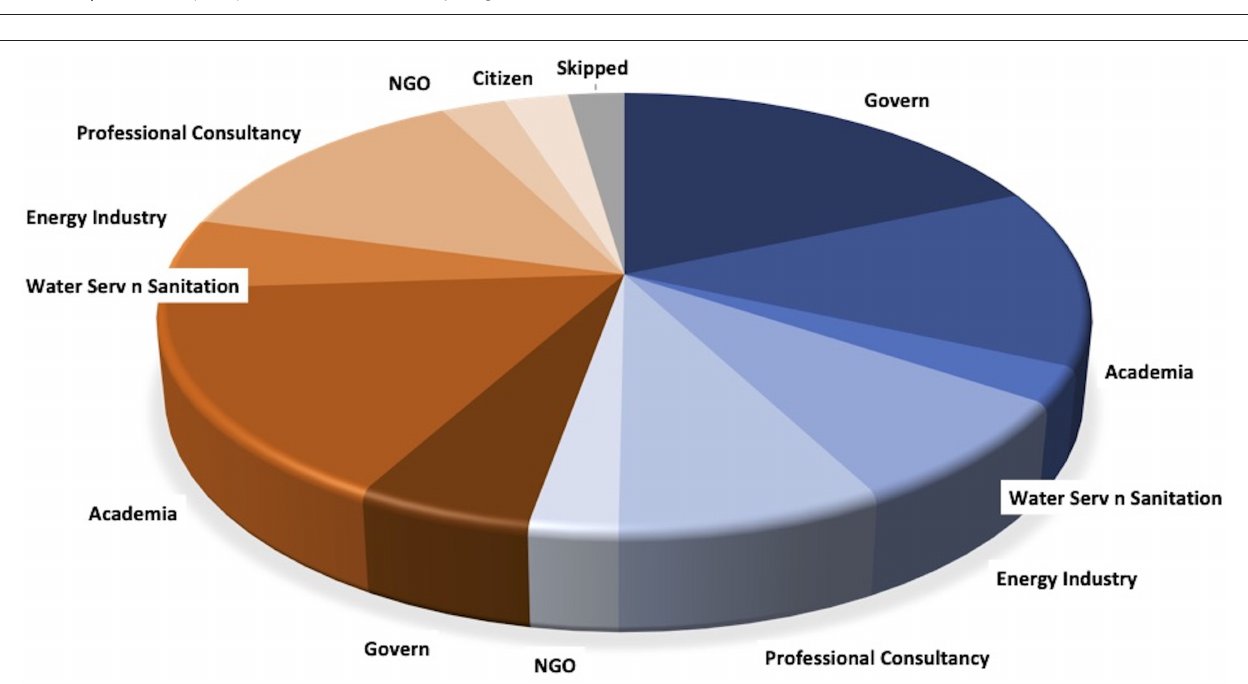
FIGURE 3 | Stakeholder perception on water and electricity integration in Brazil.